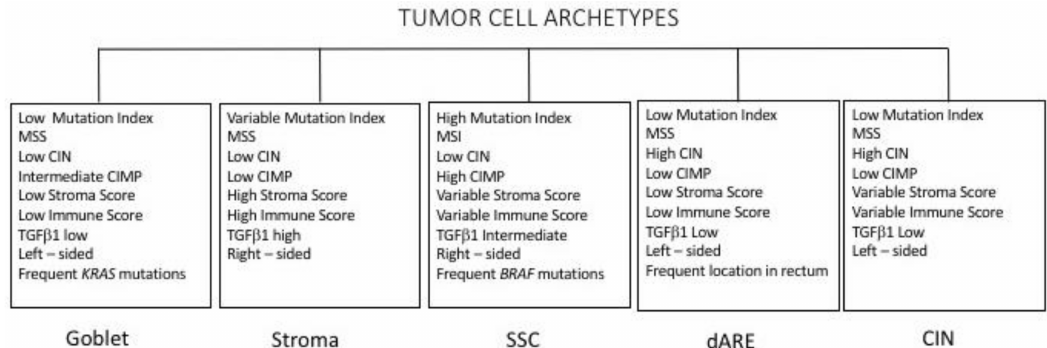
Figure 10. Classification of colorectal cancers into five tumor archetypes. This classification is based on gene expression data on the cancer cell and tumor microenvironment. This classification system is based on the study of Bramsen et al. [264]. SSC: serrated similar cancer; dARE: depleted AU-rich elements; CIN: chromosomal